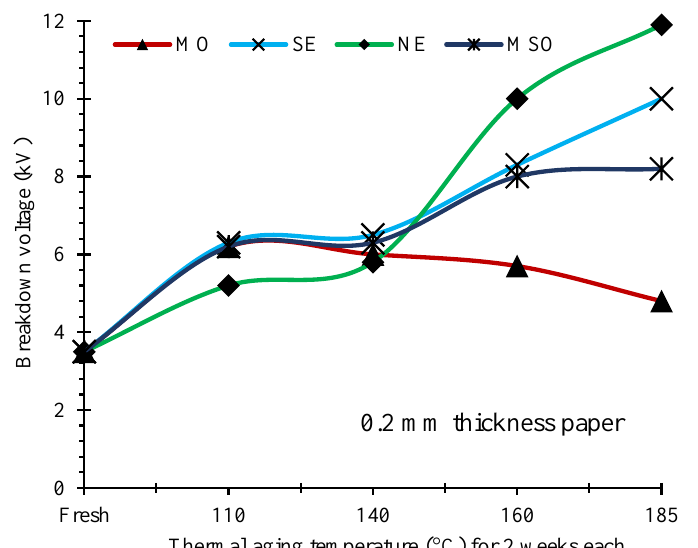
Figure 8. Change in paper BDV with the diffusion of various insulating oils for 0.2 mm thickness papers with thermal stresses.